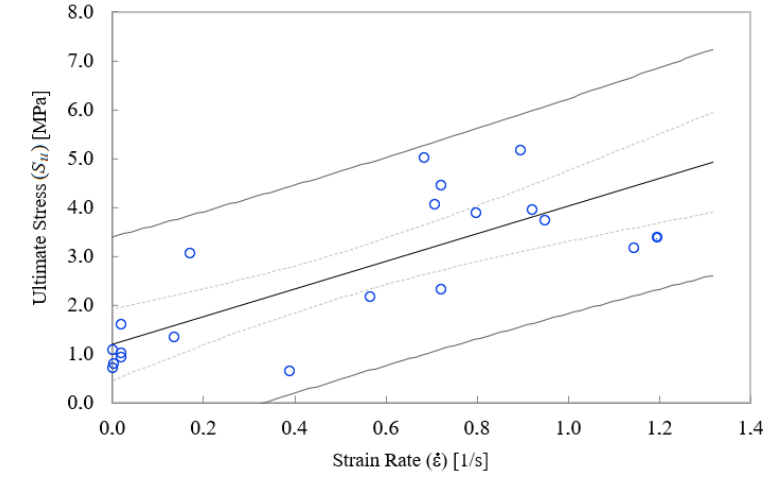
Figure 1. Scatterplot of ultimate stress vs. strain rate for low values of strain-rate a significant relation exists ( p -value <